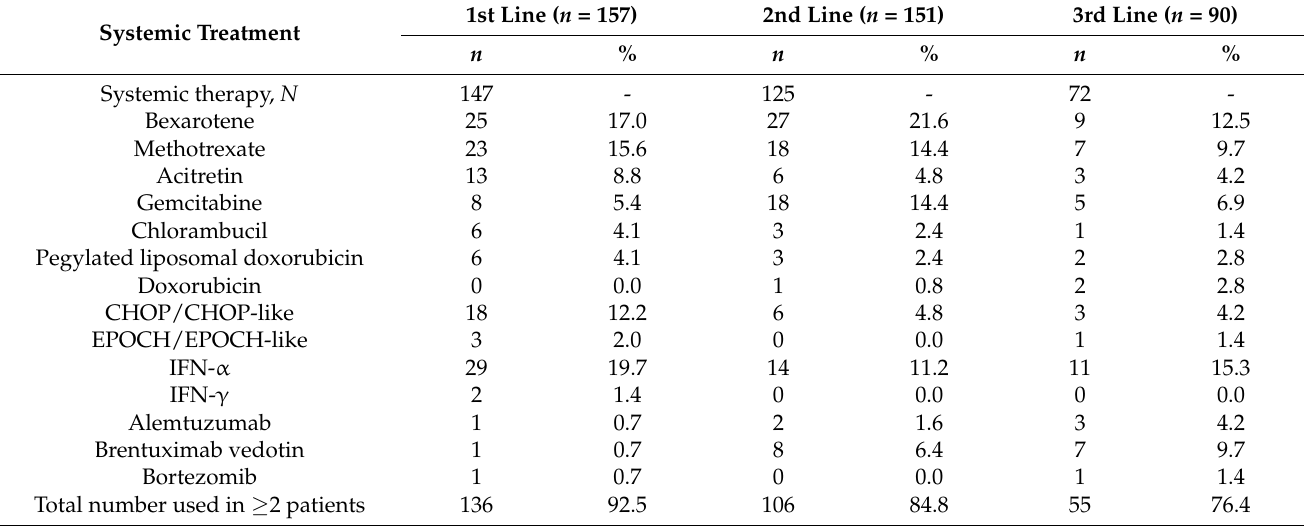
Table 4. Regimens used by 2 or more patients in at least one line of